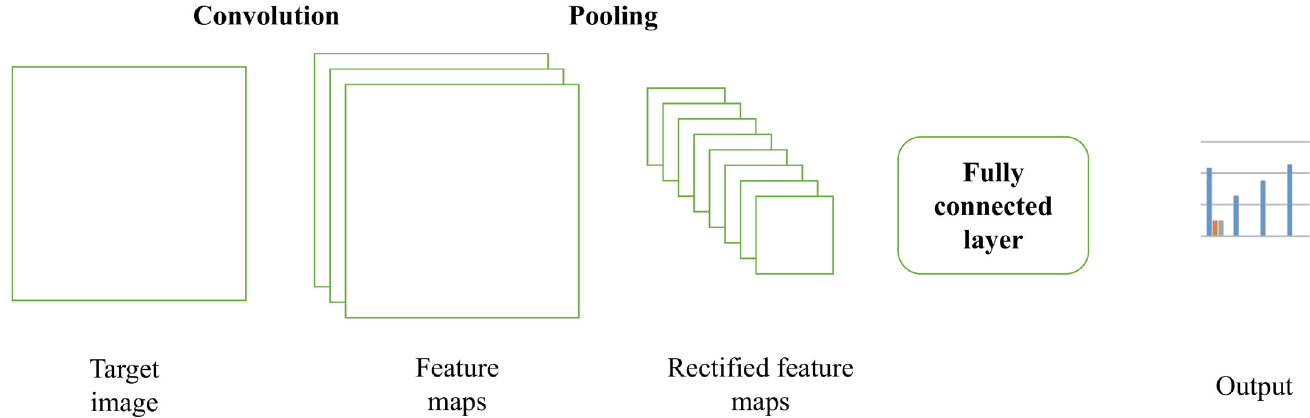
Fig 1. CNN algorithm for image recognition. An intuitive